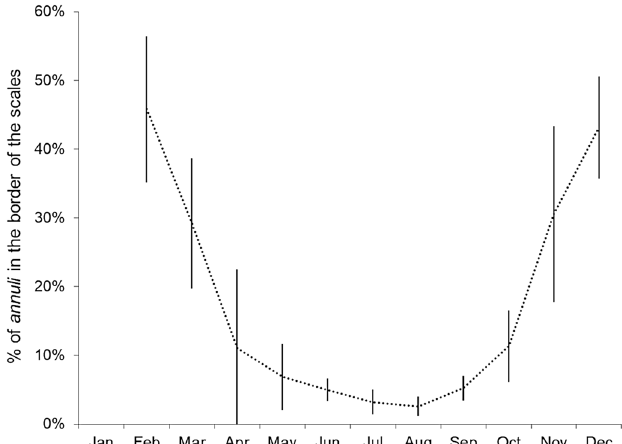
Fig. 5. Monthly proportion of Pagrus pagrus sampled in southern Brazil aged 2 to 6 with the annuli in the border of the scales ( n = 2692). Vertical bars represent 95% con fi dence intervals.